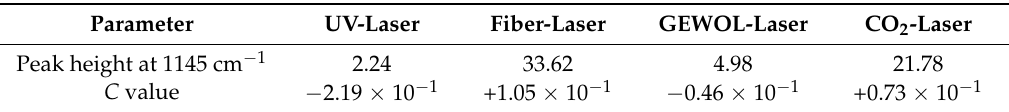
Table 3. Characteristic, analytical parameters for the laser-treated